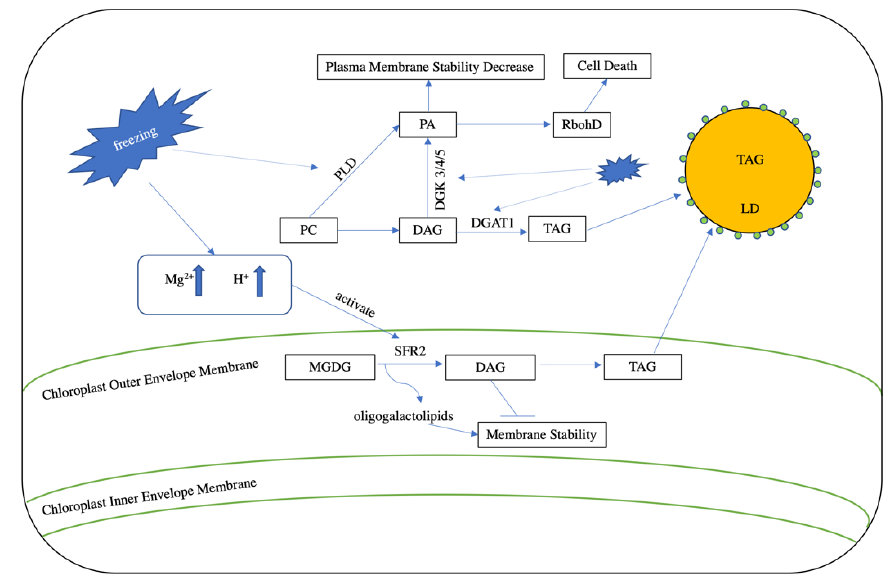
Figure 3. Lipid turnover under freezing stress. During freezing stress, cellular dehydration increases the concentration of Mg 2 + and cellular acidity. The induced cellular leakage then transports Mg 2 + and protons into the chloroplast outer envelope membrane and activates the function of SENSITIVE TO FREEZING2 (SFR2). SFR2 converts MGDG into oligogalactolipids and DAG. Oligogalactolipids enhance membrane stability, whereas DAG reduces stability. DGAT1 can sequester DAG into TAG to decrease membrane damage. In addition, freezing stress also elevates PA levels through the action of phospholipase D (PLD) and the DAG kinase 3 / 4 / 5 (DGK 3 / 4 / 5). This increase in PA decreases plasma membrane stability and induces the formation of NADPH oxidase (RbohD), which in turn leads to the production of reactive oxygen species (ROS) and cell death.